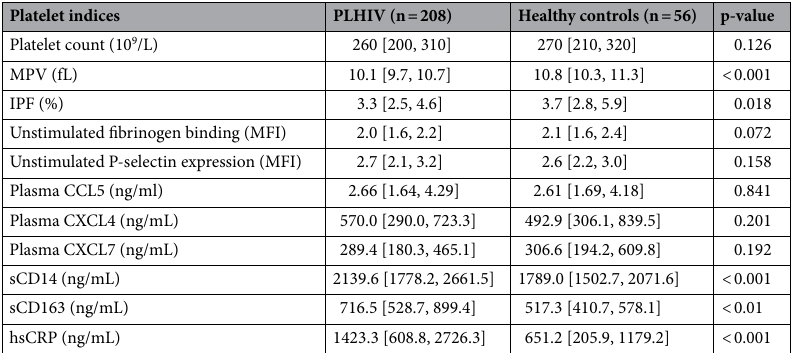
ity were investigated by assessing the oxygen consumption rate (OCR; measure for mitochondrial respiration/ OXPHOS) and the acidification rate (ECAR; measure for glycolysis). There was a trend towards lower baseline platelet mitochondrial respiration (OCR in pmol/min) in PLHIV compared to controls (Fig. 2D; 47.4 pmol/min (SD: 11.3) vs 55.1 pmol/min (SD: 12.2), p = 0.084). Additionally, PLHIV had a smaller increase in OCR after Fig. 2A–C) compared to matched controls. The fraction of the maximal mitochondrial capacity (maximal OCR after stimulation with the uncoupling agent FCCP) used after ex vivo platelet stimulation with TRAP was high in both groups (Supplemental Fig. S6d; p > 0.1). This suggests that maximal mitochondrial capacity is a limiting factor in platelet activation. Conversely, there was no difference between groups in ECAR (glycolysis) at baseline (Fig. 2B; HIV: 16.0 mpH/min (SD: 3.4) vs HC: 14.7 mpH/min (SD: 2.4), p > 0.1) or after ex vivo stimulation. The increase in mitochondrial respiration (OCR) after ex vivo stimulation significantly correlated with mtDNA pl (R = 0.77, p = 0.045, n = 7, Fig. 3A) and a similar trend was found for basal mitochondrial respiration of platelets (R = 0.61, p = 0.14, n = 7, Fig. 3B). Taken together, our data suggest that the lower platelet mtDNA in PLHIV in associated with a concurrent reduction in mitochondrial respiration capacity (OXPHOS) without a compensatory increase in glycolysis. HIV infection is associated with platelet dysfunction. Next, we explored the possible consequences of lower mtDNA pl and mitochondrial dysfunction for platelet parameters and function. Platelet counts were similar between PLHIV and healthy controls (Table 2), but PLHIV had smaller platelets (mean platelet volume: